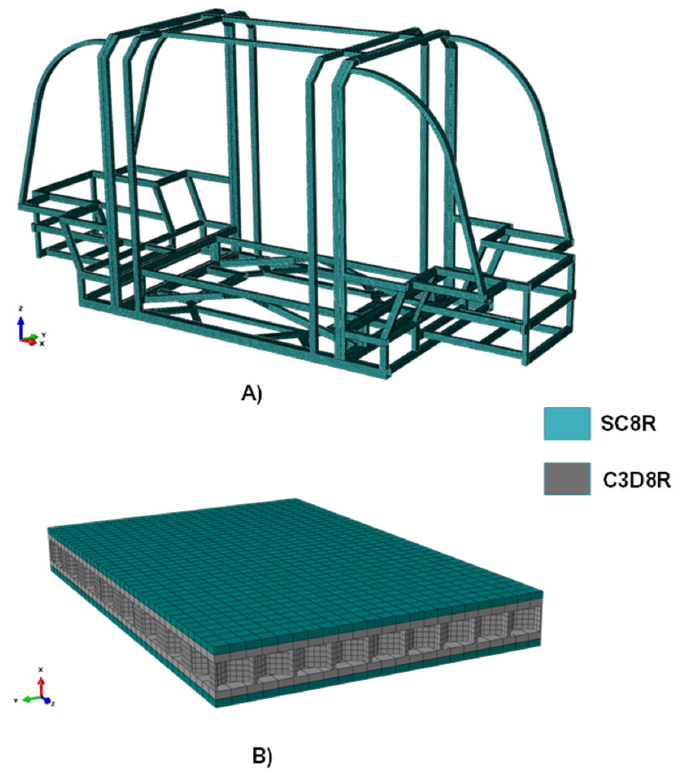
Figure 5. Finite element discretization. ( A ) Computational grid of the chassis with SC8R elements, ( B ) Computational grid of the shock absorber with SC8R elements (in green) and C3D8R elements (in grey).